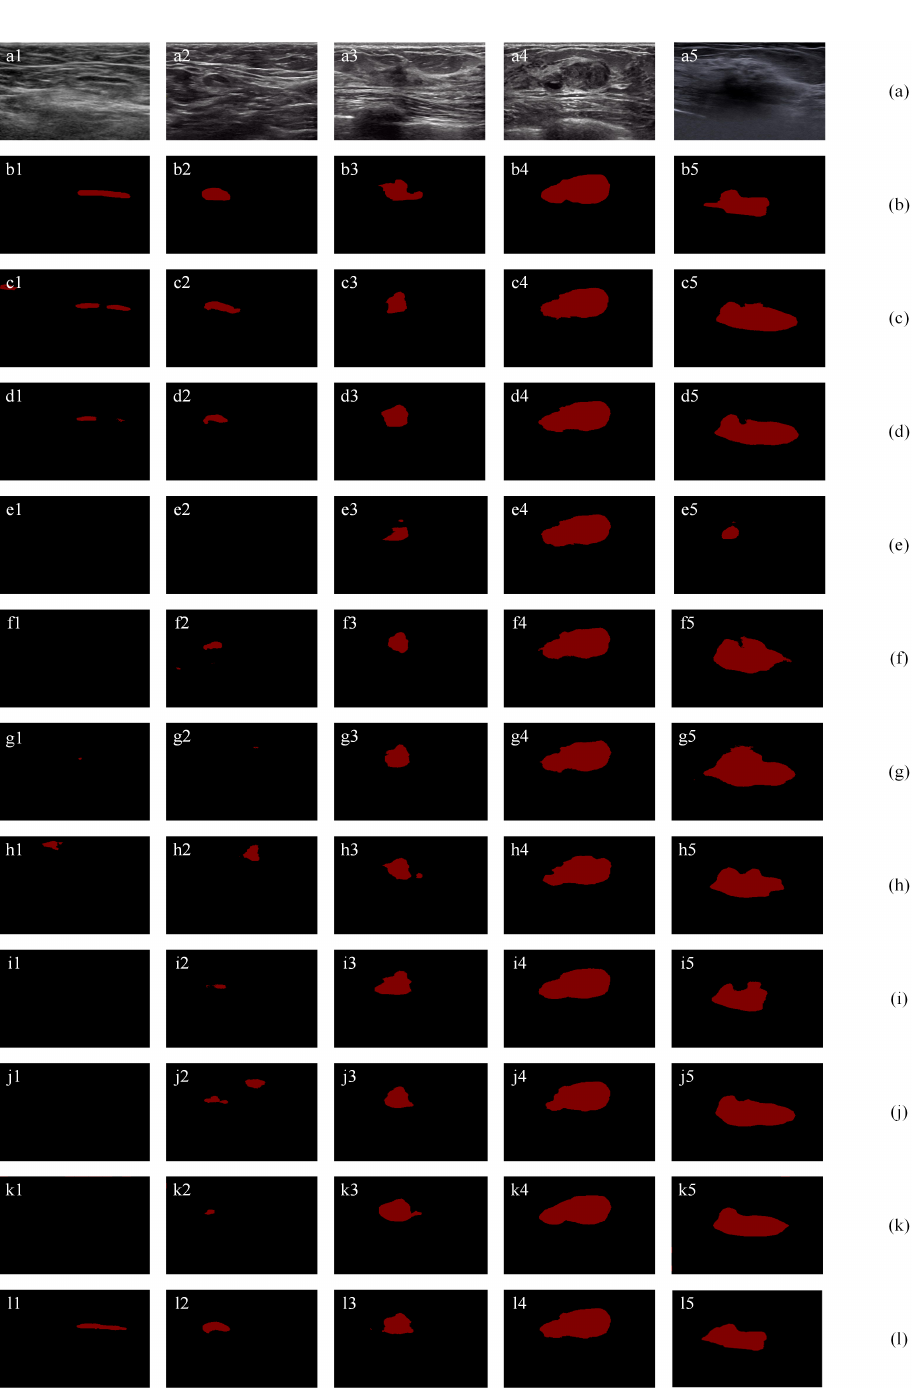
Figure 12. Segmentation results using public dataset: ( a ) original images; ( b ) ground truths; ( c ) results of ResNet-101 with self-attention mechanism; ( d ) results of a SE-Net (ResNet-101); ( e ) results of attention U-Net; ( f ) results of ResNet-50; ( g ) results of ResNet-101; ( h ) results of Deeplab; ( i ) results of PSPNet; ( j ) results of U-Net with wavelet transform; and ( k ) results of FCN-8s; ( l ) results of proposed